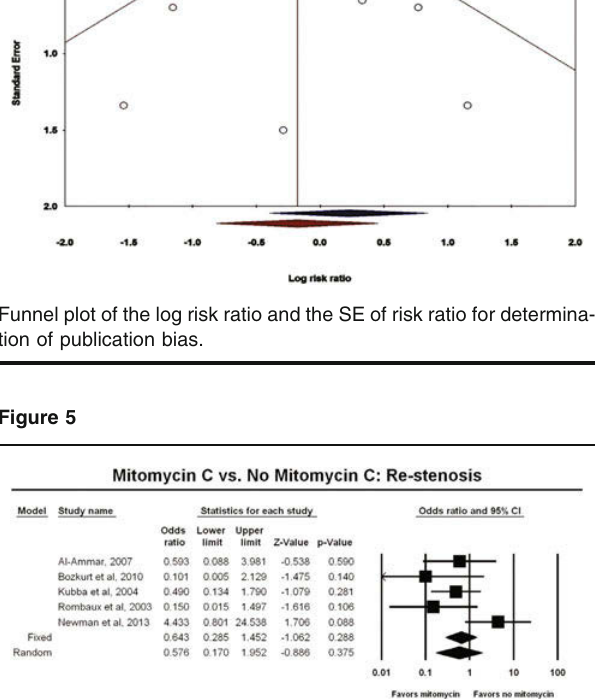
Showed the forest plot for meta-analysis of studies comparing mito- mycin C versus no mitomycin C as regards the incidence of resteno- sis. CI, confidence